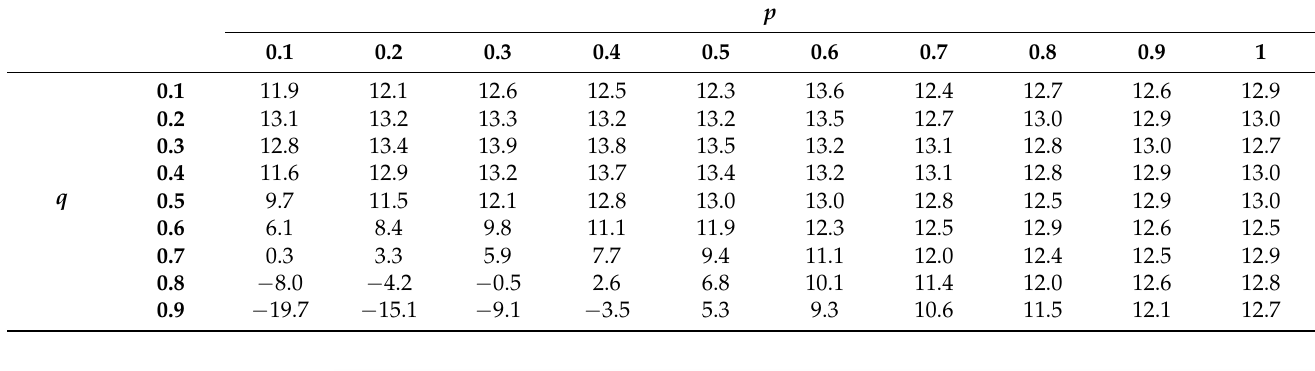
profitable scenarios.